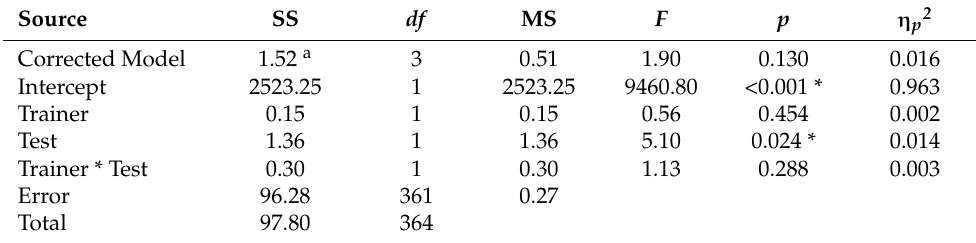
Table 10. Two-way ANOVA for knowledge of trauma-informed educators’ roles ( n = 365). Source SS df MS